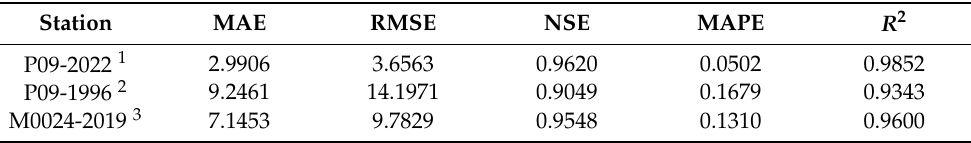
Table 5. Error metrics of the maximum recorded rainfall p max ( t d ) recorded at different durations, with respect to the estimated rainfall ˆ p max ( t d ) of the IDF curves at T = 20 years.